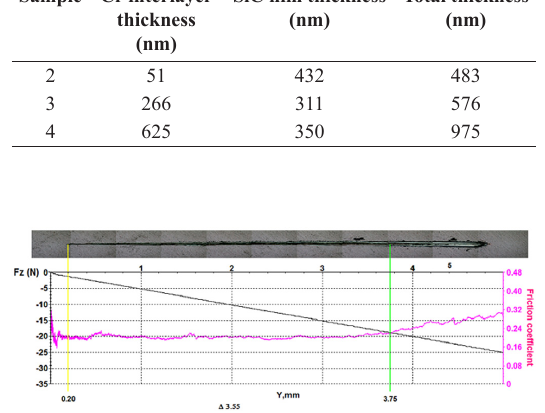
Figure 4. Friction coefficient (pink) and applied load (black) as a function of track distance obtained for scratching test for sample